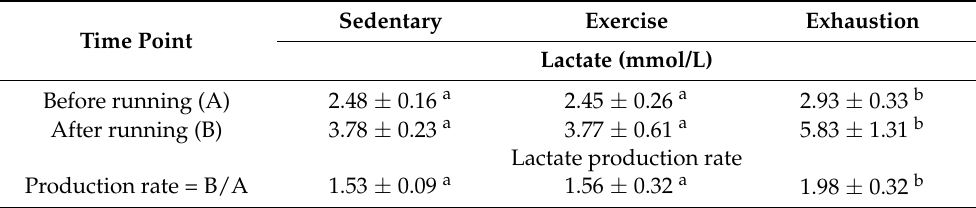
icantly when p < 0.05.